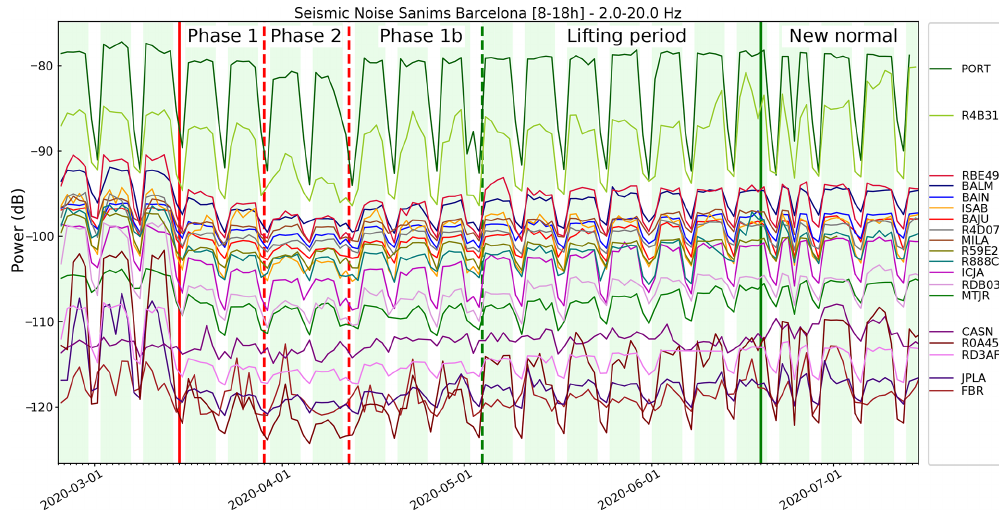
Figure 4. Variation in the power of the seismic acceleration in the 2–20Hz band for all the investigated sites, expressed in dB. The colored lines show the daily average during business hours. The vertical bars show the start dates of the phase 1 lockdown period (solid red bar), the period with stricter measures (phase 2, dashed red lines) and the beginning of the lifting period (dashed green line) and the so-called “new normal” (solid green line). Light green shadings show weekdays.